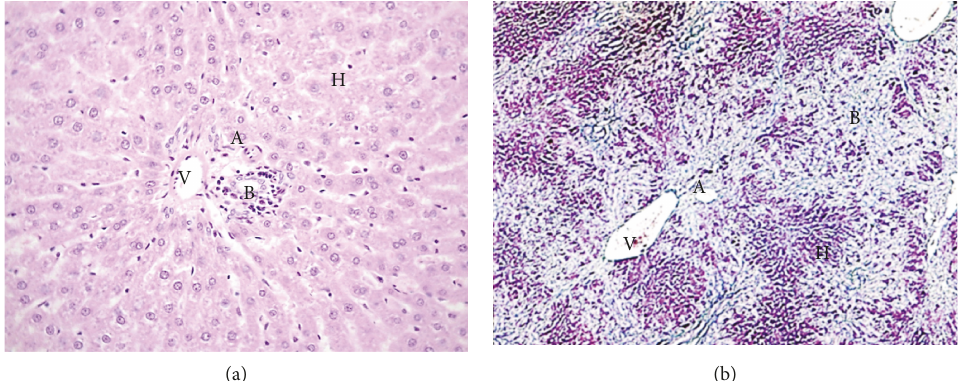
Figure 1: Histological images of a normal rat (a) and long-term cholestatic (b) liver parenchyma. Note the severe epithelial bile cell proliferation associated with fi brosis and hepatocyte death by necrosis and apoptosis in (b). V: portal vein, A: hepatic artery, B: biliary duct, and H: